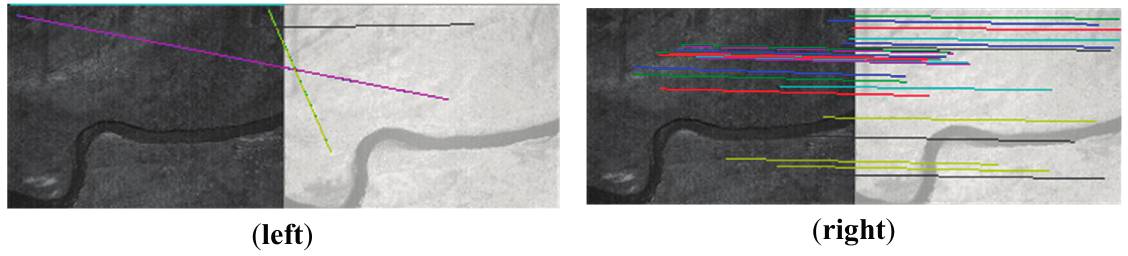
Figure 9. Image registration; ( left ) the result obtained by using the RANSAC directly; ( right ) the result obtained by using our method.